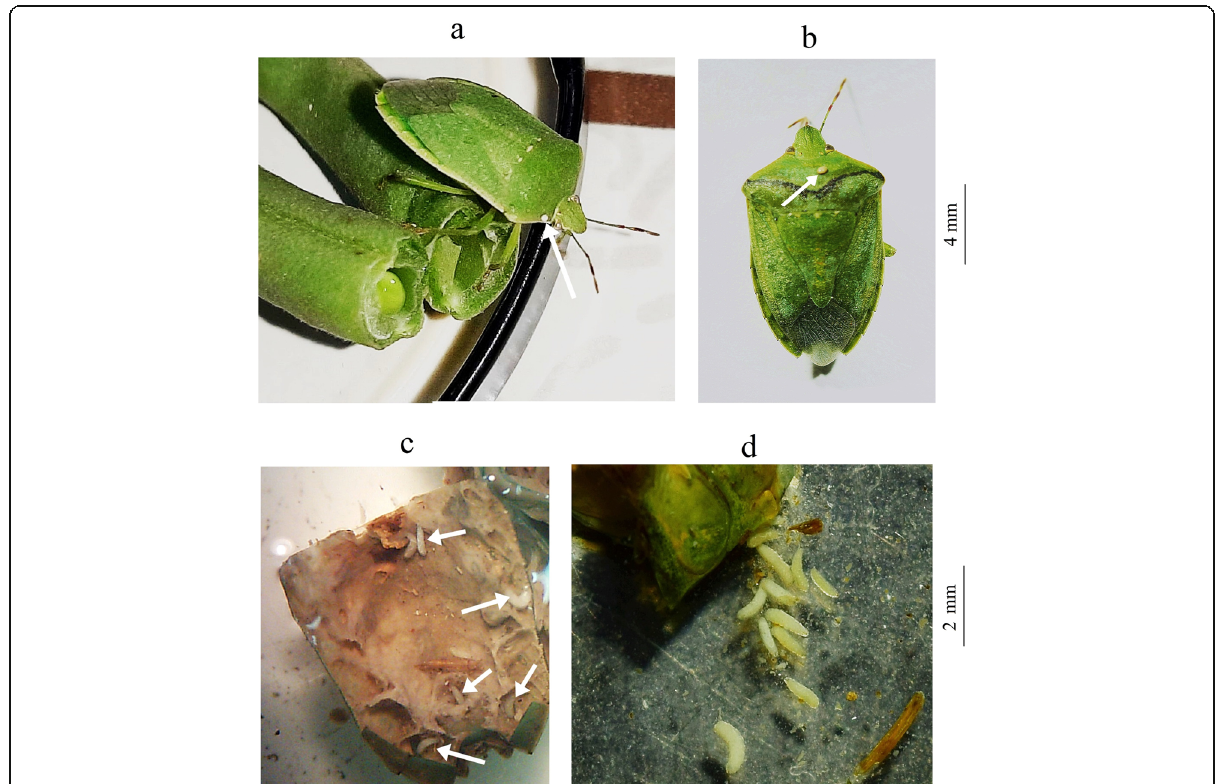
Fig. 1 a , b Adult specimens of Nezara viridula (L.) bearing eggs of Trichopoda pennipes on the pronotum. c Larvae of T. pennipes inside a dissected N. viridula specimen. d Larvae of T. pennipes released from a dissected N. viridula